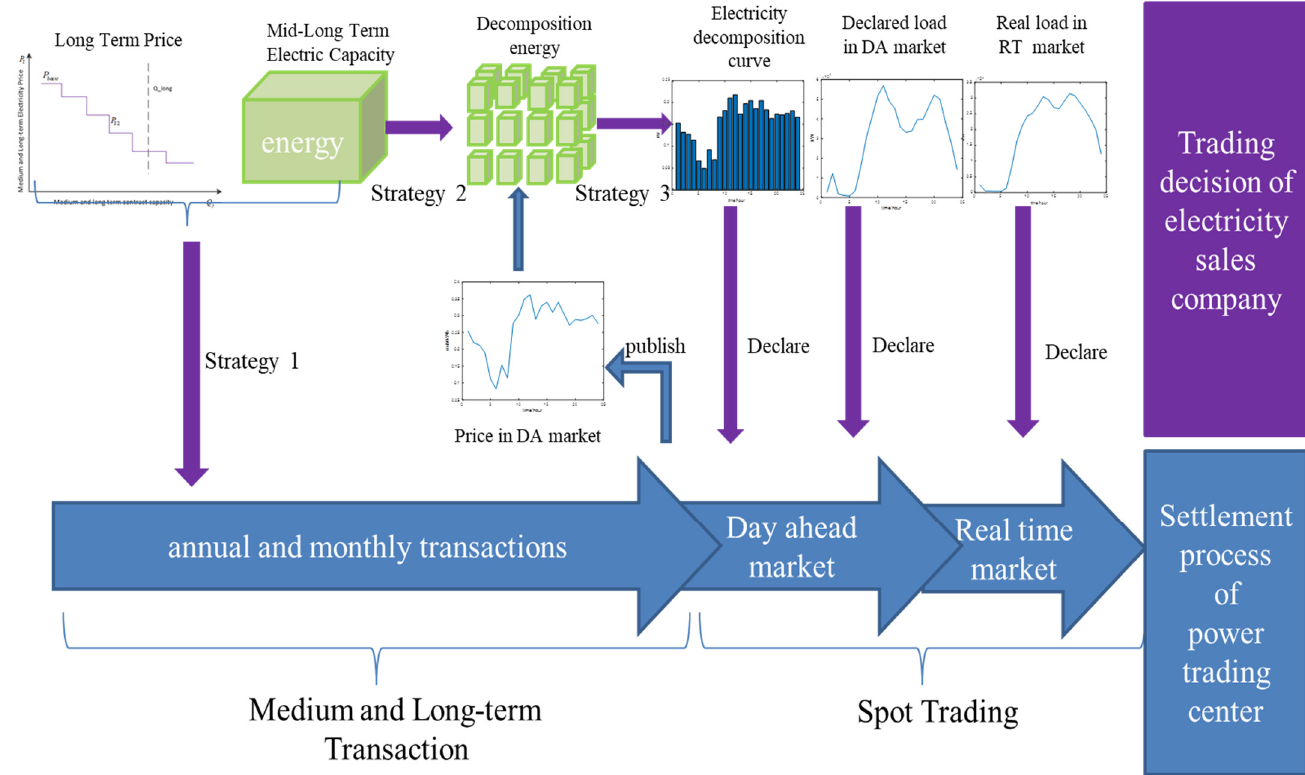
Figure 5. Transaction process of China ’ s power market.